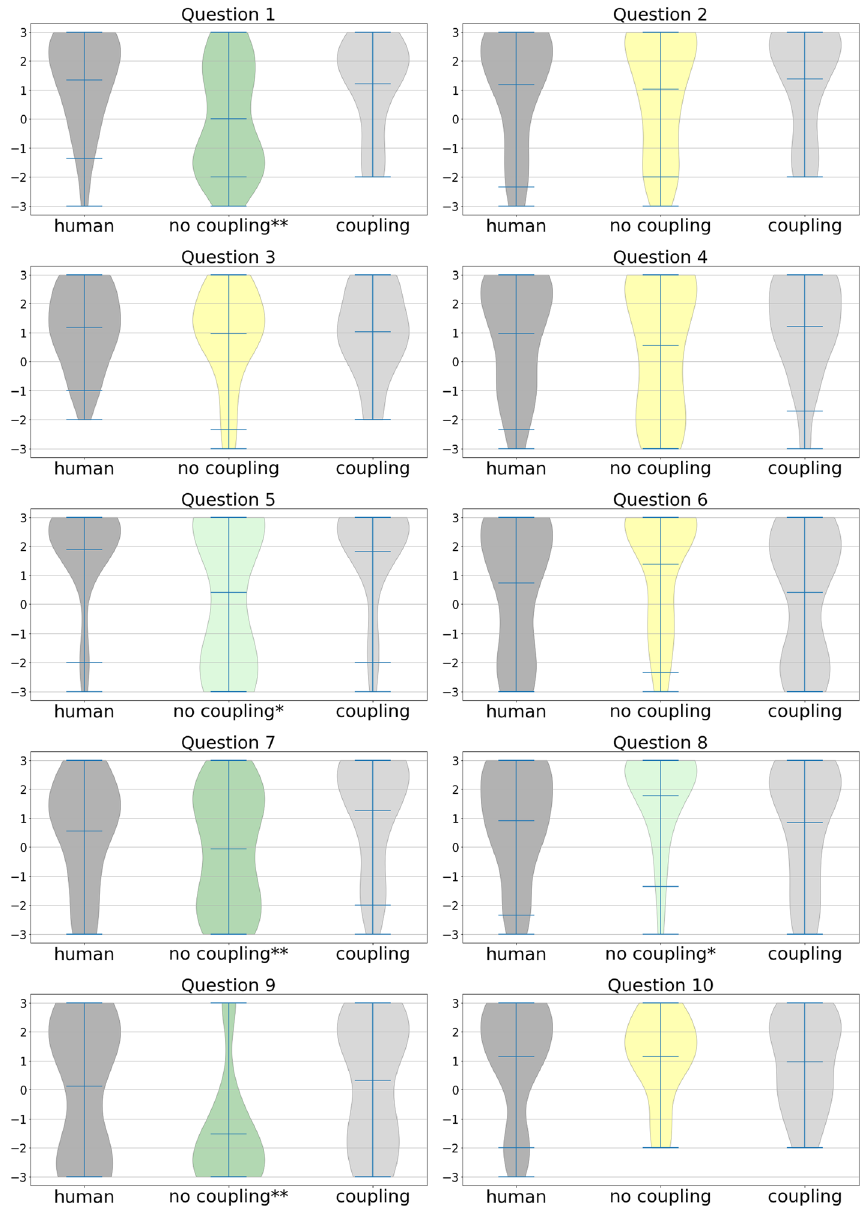
Figure 2. Violin plots of the graded responses to the questions. First column shows responses when participants did the task with another human (dark grey). No question showed a significant difference when comparing another human with the coupling condition. The second column shows responses when participants did the task with an automated virtual human in the no coupling condition. Responses in green are the responses which are significantly different from the coupling condition (p< 0.05). Light green and * in the label indicate a small size effect. Dark green and ** in the label indicate a moderate size effect. The third column shows responses when participants did the task with an autonomous virtual character in the coupling condition. The mean, 0.95 confidence intervals, and the extreme values are drawn as horizontal